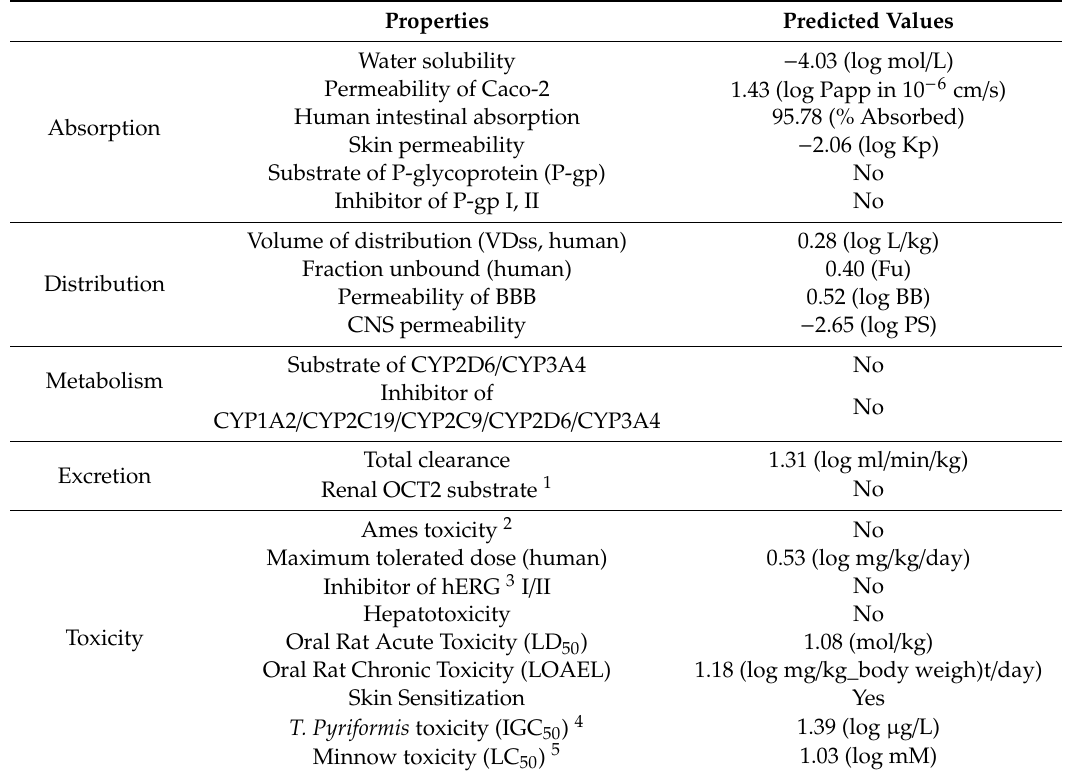
Table 4. In silico ADMET properties of